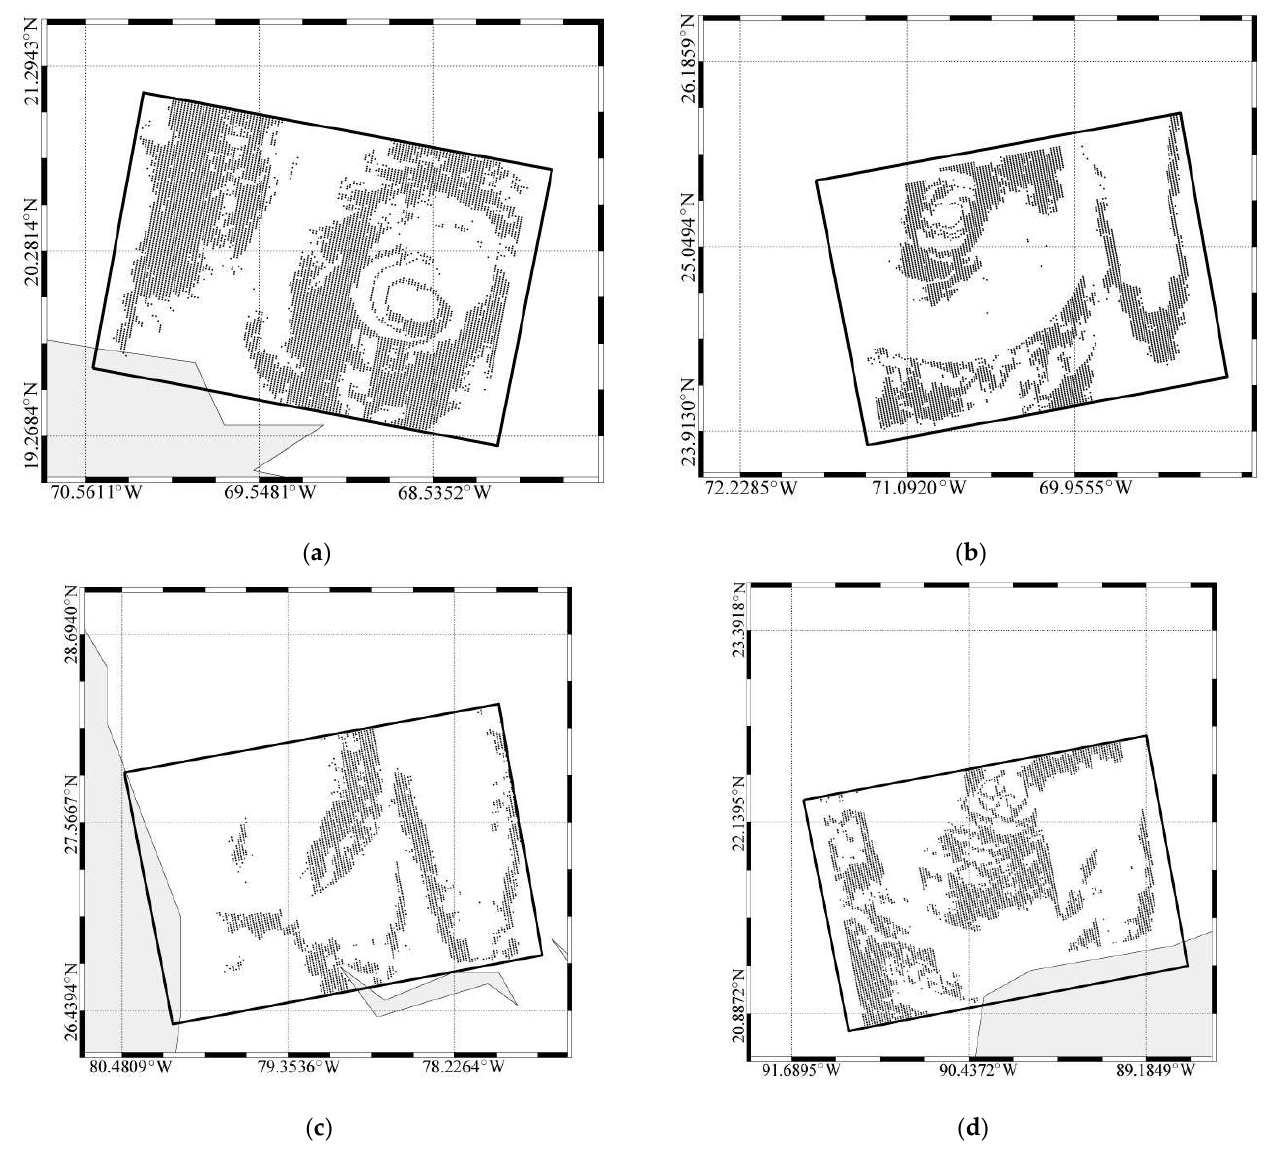
Figure 8. Maps of rain cell identification: ( a – d ) refer to the SAR scenes shown in Figure 1a–d.